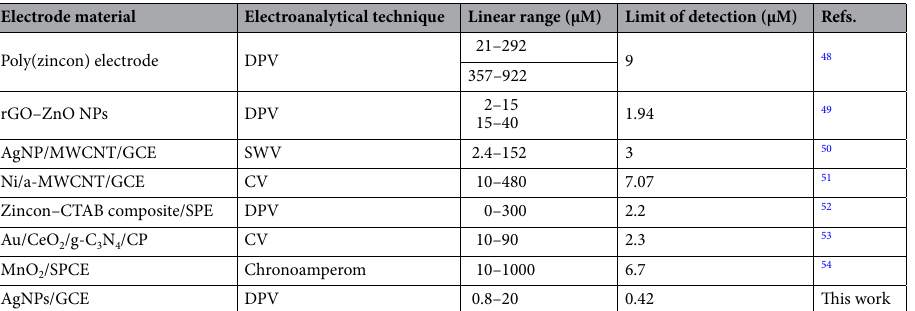
Table 2. Comparison of the performance of our proposed sensor with other phenol sensors. rGO reduced graphene oxide, ZnO zinc oxide, MWCNT Multiwall carbon nanotube, SWV Square wave voltammetry, a‑MWCNT acidified multiwalled carbon nanotube, CV Cyclic voltammetry, CTAB Cetyl trimethyl ammonium bromide, SPE Screen-printed electrode, Au/CeO 2 Gold–cerium oxide, g‑C 3 N 4 graphite-carbon nitride, CP Carbon paper, MnO 2 Manganese dioxide, SPCE Screen-printed carbon electrode.